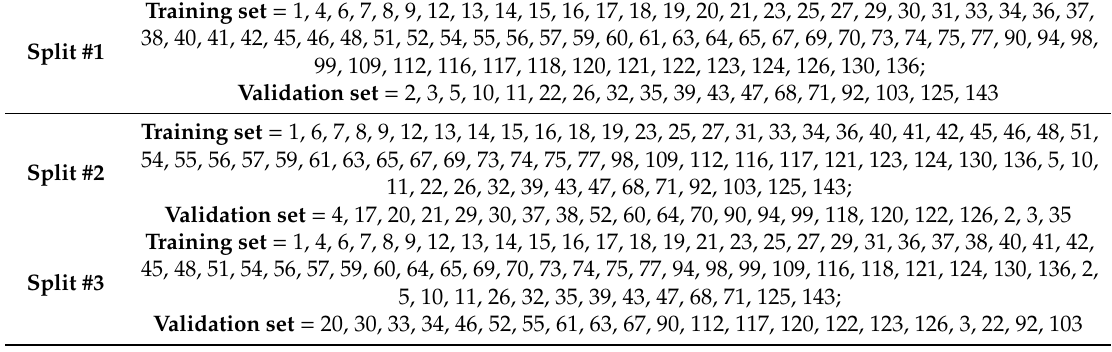
Table 2. The predictive potential of di ff erent approaches observed for di ff erent splits.